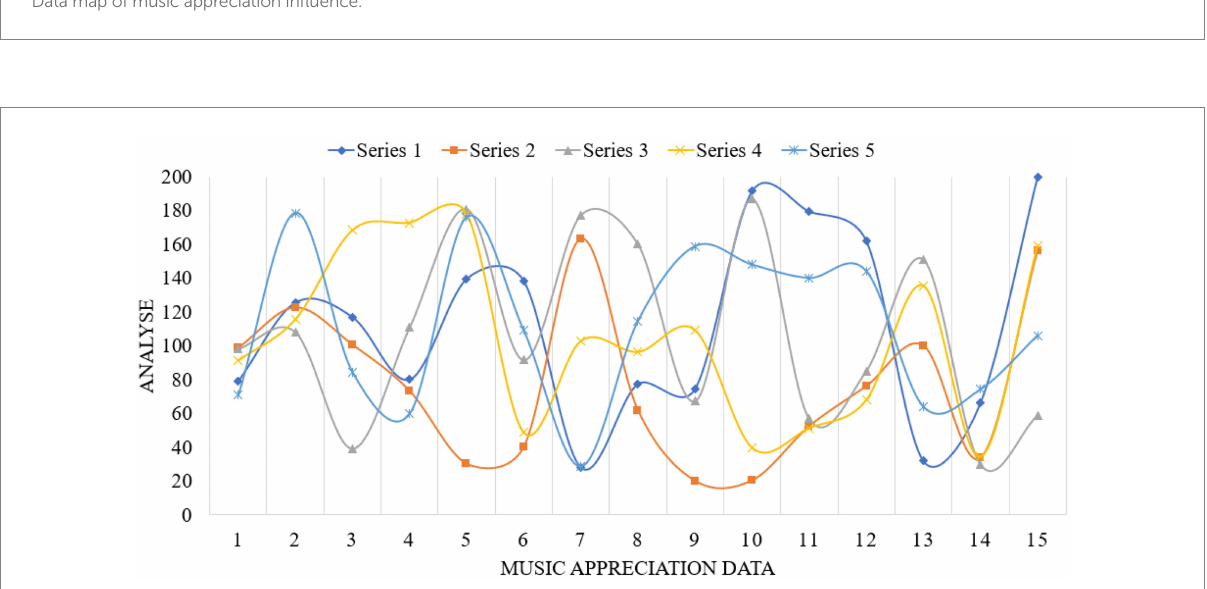
FIGURE 5 Data map of music appreciation